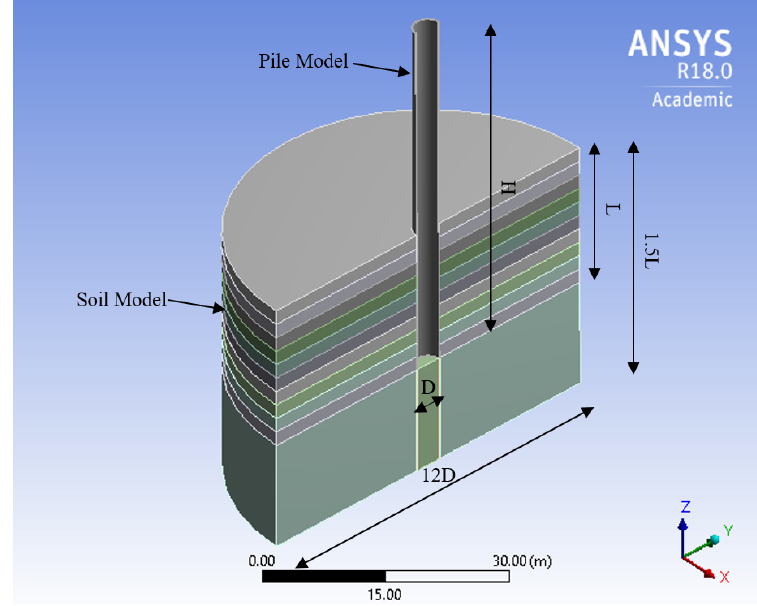
Figure 2. Symmetric model used in this research and its overall dimensions.